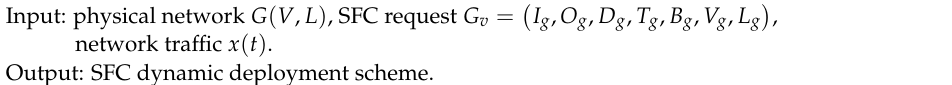
Algorithms 1 : SFC dynamic deployment algorithm based on traffic prediction and VNF